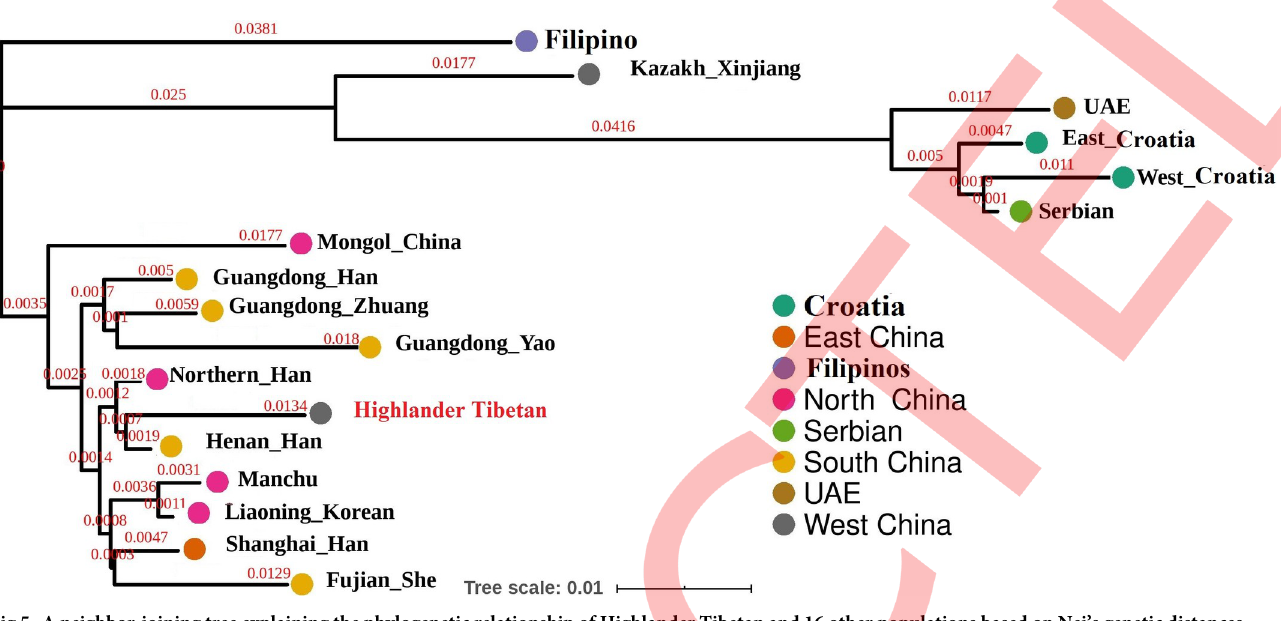
S1 Table. Hardy–Weinberg equilibrium tests in the Highlander Tibetans female popula- tion residing in Nagqu city in the north of the Tibet Autonomous Region (TAR) in China (n = 549). A sequential Bonferroni correction was applied with a threshold p-value of 0.05. S2 Table. A. Allele frequencies of the 12 X-STR loci in in the Highlander Tibetans population residing in Nagqu city in the north of the Tibet Autonomous Region (TAR) in China (n = 549). B. Fisher Exact test for population differentiation per locous between allelic frequen- cies of male and female sample in the Highlander Tibetans population residing in Nagqu city in the north of the Tibet Autonomous Region (TAR) in China (n = 549). S3 Table. A. Linkage disequilibrium tests in the Highlander Tibetans female population resid- ing in Nagqu city in the north of the Tibet Autonomous Region (TAR) in China (n = 300). A sequential Bonferroni correction was applied with a threshold p-value of 0.05. B. Linkage dis- equilibrium tests in the Highlander Tibetans male population residing in Nagqu city in the north of the Tibet Autonomous Region (TAR) in China (n = 249). A sequential Bonferroni correction was applied with a threshold p-value of 0.05. S4 Table. Haplotype frequencies for the 4 linkage groups in the male Highlander Tibetan population residing in Nagqu city in the north of the Tibet Autonomous Region (TAR) in